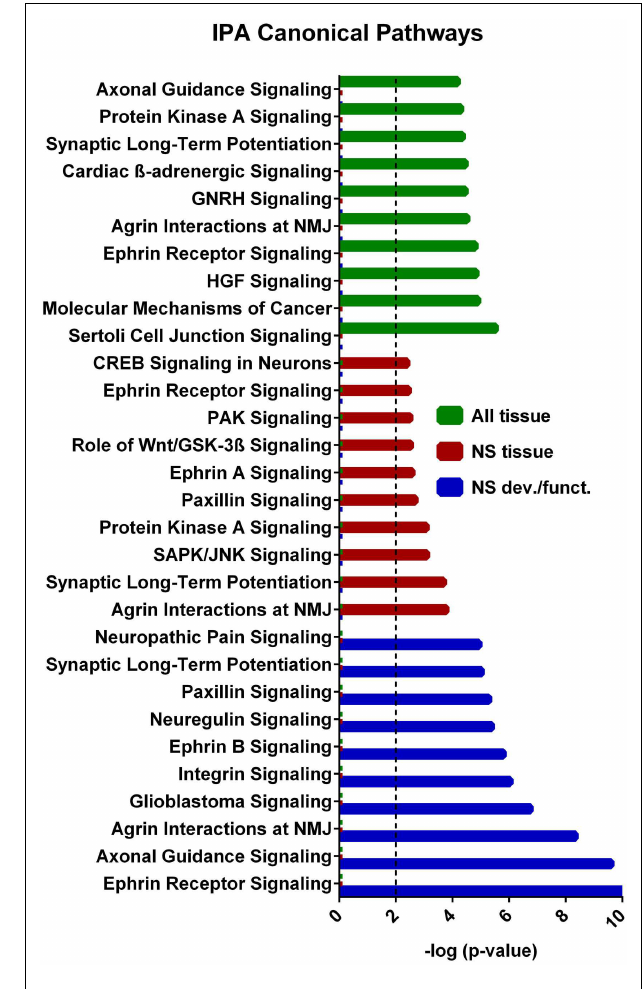
FIGURE 4 | IPA canonical pathway analyses from each tier of core analysis .The X axis represents negative log p values based on the probability that molecules in the uploaded dataset were included the predefined IPA canonical pathways by true association as opposed to inclusion of molecules based on chance alone. Pathways not involved in nervous system were removed from the nervous system tissue analysis and nervous system development and function graphical displays. Only the top 10 pathways with the largest negative log p values are shown.The dashed line indicates the threshold of significance for a p value of 0.01. GNRH, gonadotropin-releasing hormone; HGF, hepatocyte growth-factor; NMJ, neuromuscular